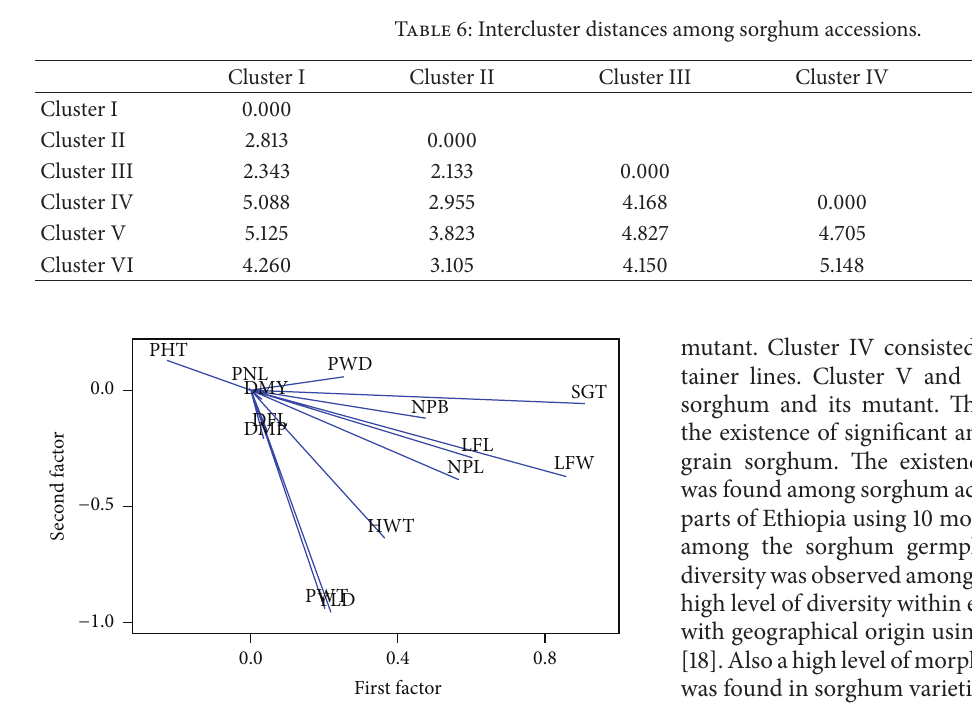
Figure 1: Loading plot of quantitative traits based on factor